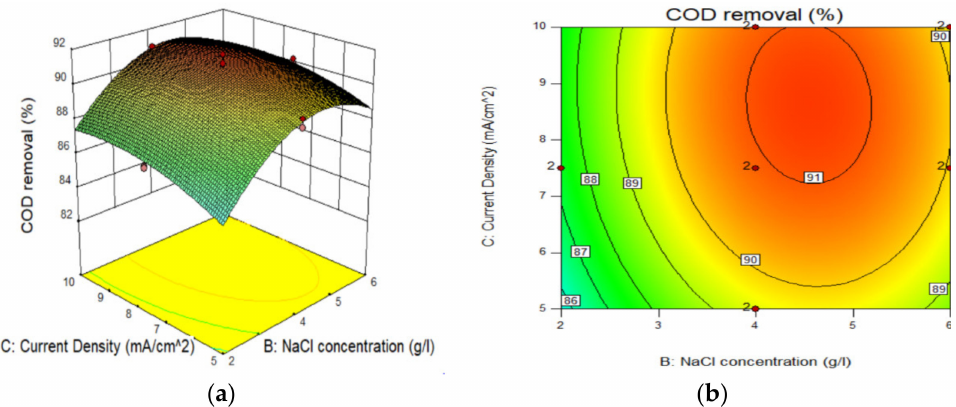
Figure 7. ( a ) Three-dimensional (3D) response graph and ( b ) contour plot for the NaCl concentration and current